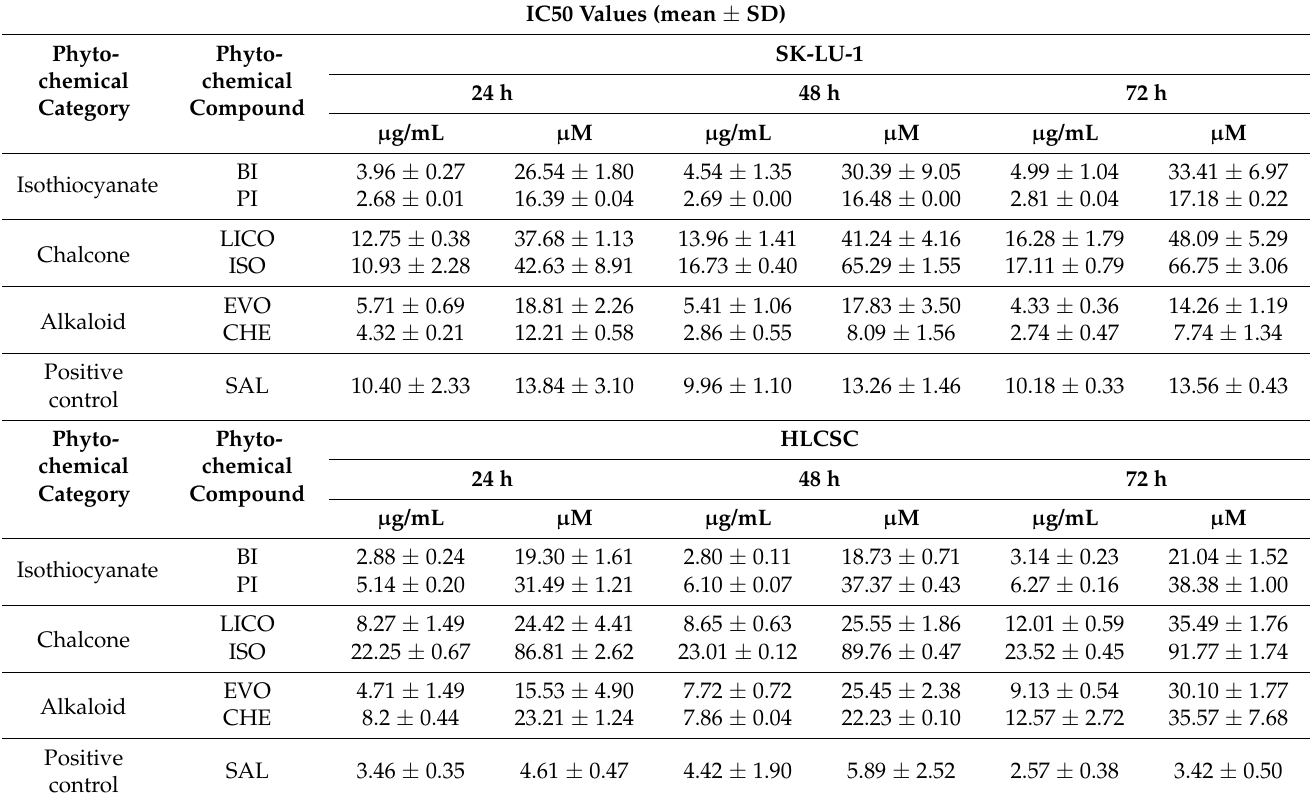
Table 2. IC 50 values of alkaloids, chalcones and isothiocyanates in SK-LU-1 and